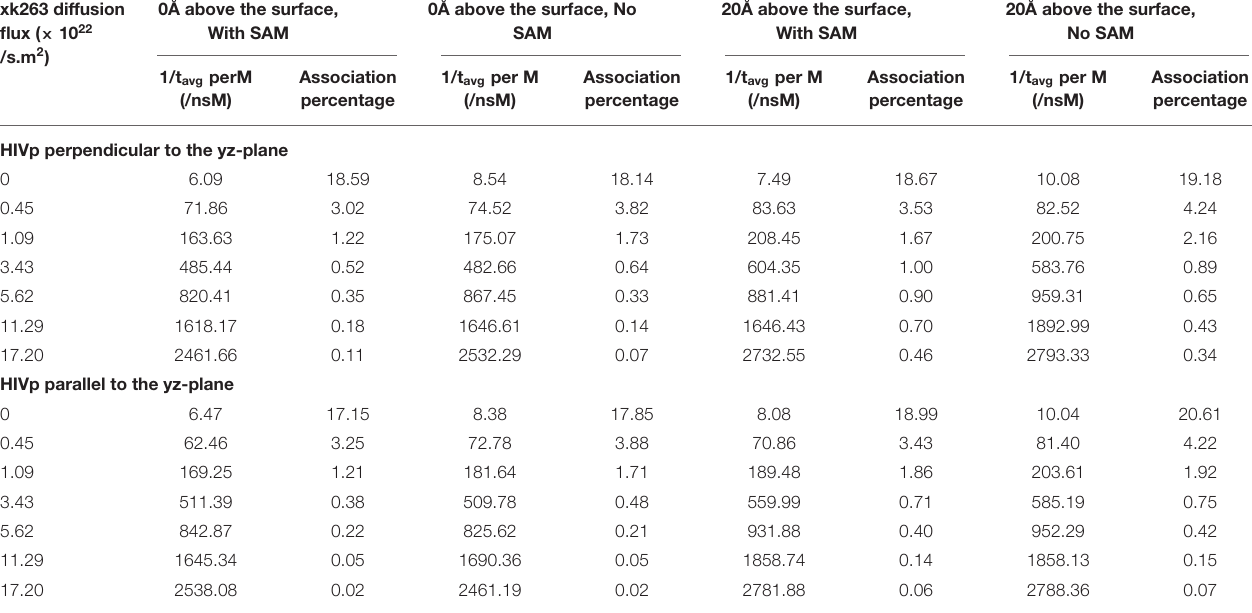
TABLE 4 | Inverse of average association time per molarity and percentage of successful binding with different xk263 diffusion fluxes. xk263 diffusion flux ( × 10